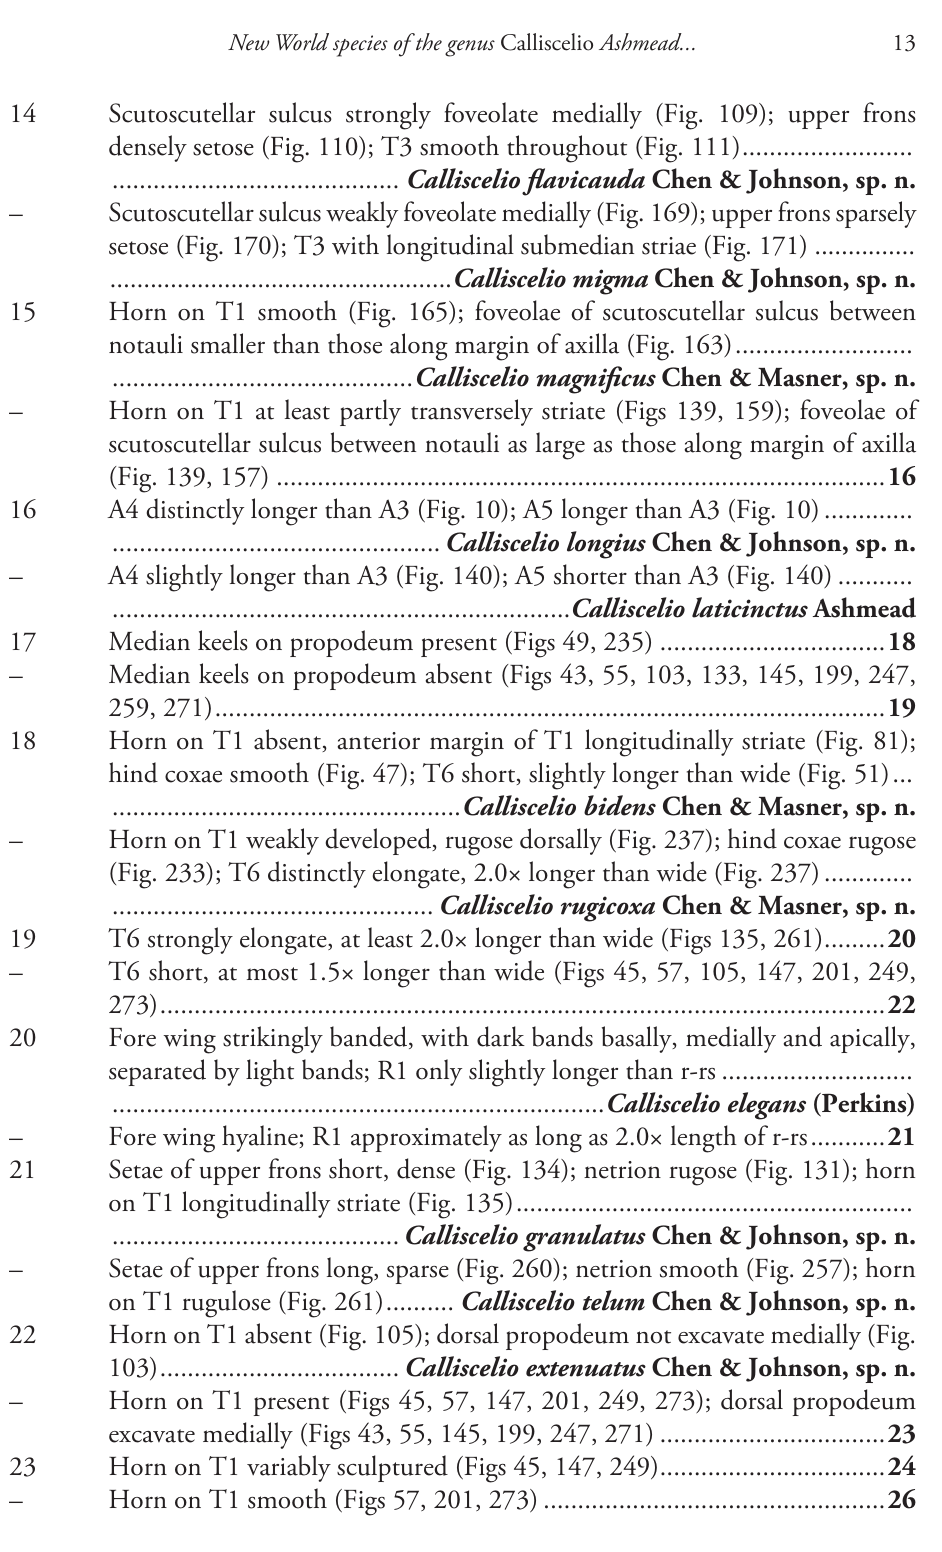
Setae of upper frons long, sparse (Fig. 260); netrion smooth (Fig. 257); horn on T1 rugulose (Fig. 261) .......... Calliscelio telum Chen & Johnson, sp. n. 22 Horn on T1 absent (Fig. 105); dorsal propodeum not excavate medially (Fig. Horn on T1 present (Figs 45, 57, 147, 201, 249, 273); dorsal propodeum excavate medially (Figs 43, 55, 145, 199, 247, 271) ................................. 23 23 Horn on T1 variably sculptured (Figs 45, 147, 249) .................................